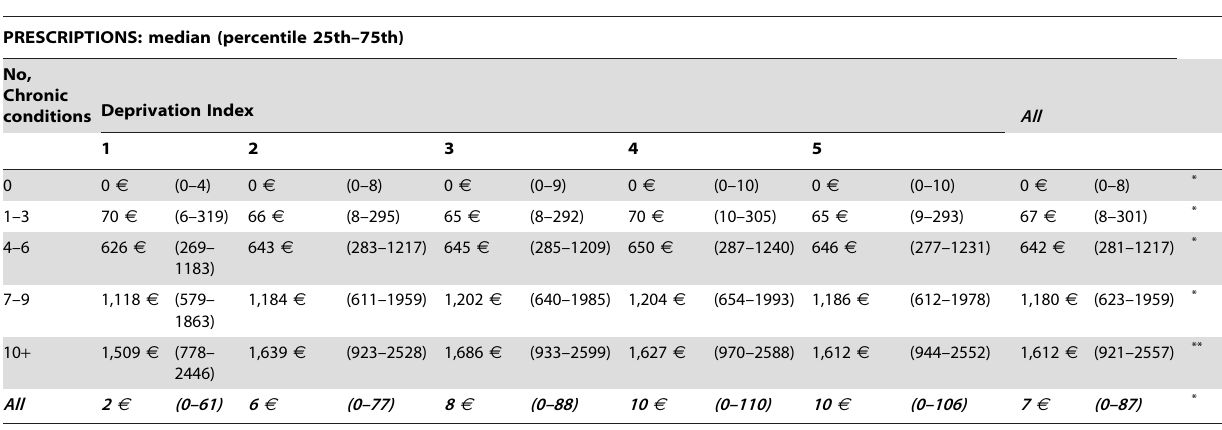
Table 5. Comparison of medians of prescriptions costs per patient, depending on number of chronic diseases and deprivation